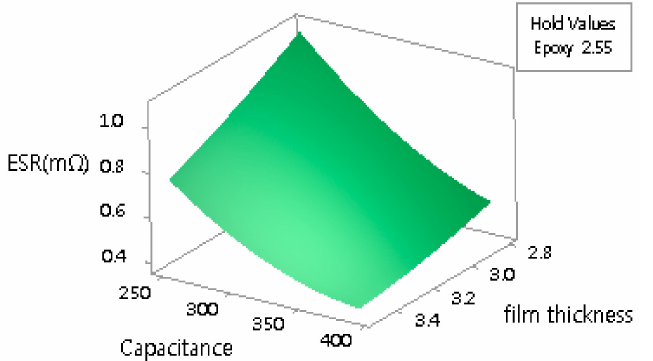
Figure 7. Response surface analysis results for Arms/ (cid:52) t versus film thickness and film